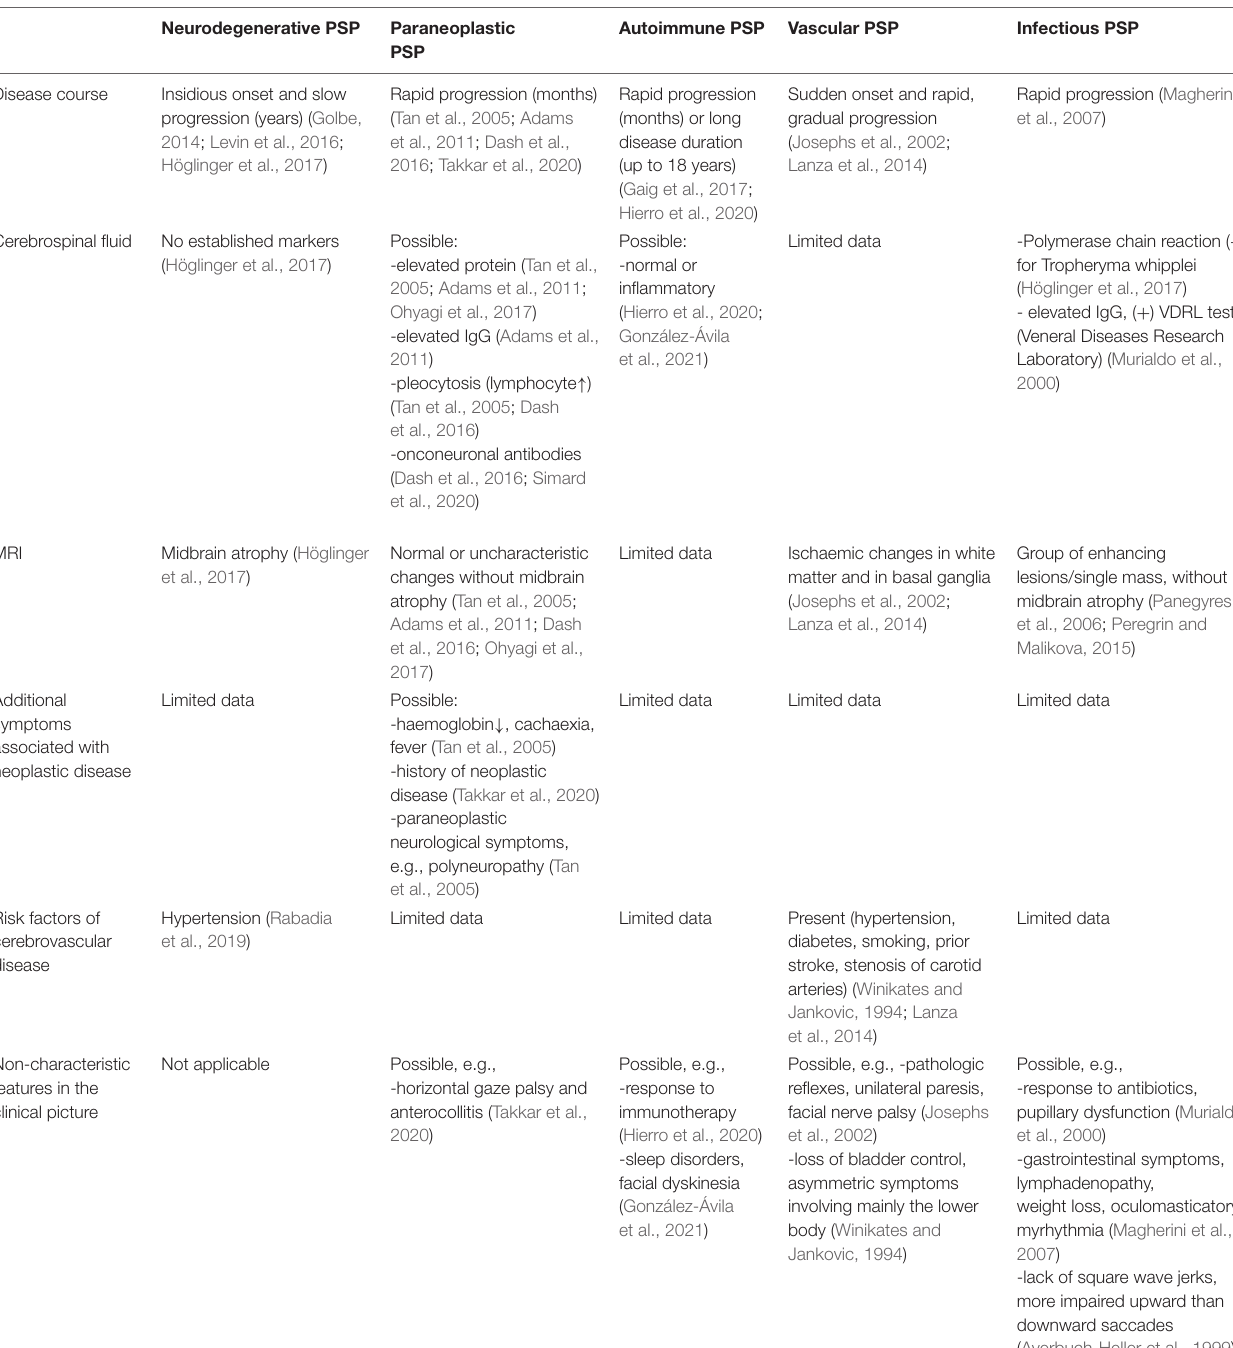
TABLE 1 | Comparison of paraneoplastic, autoimmune and vascular Progressive supranuclear palsy (PSP) with neurodegenerative